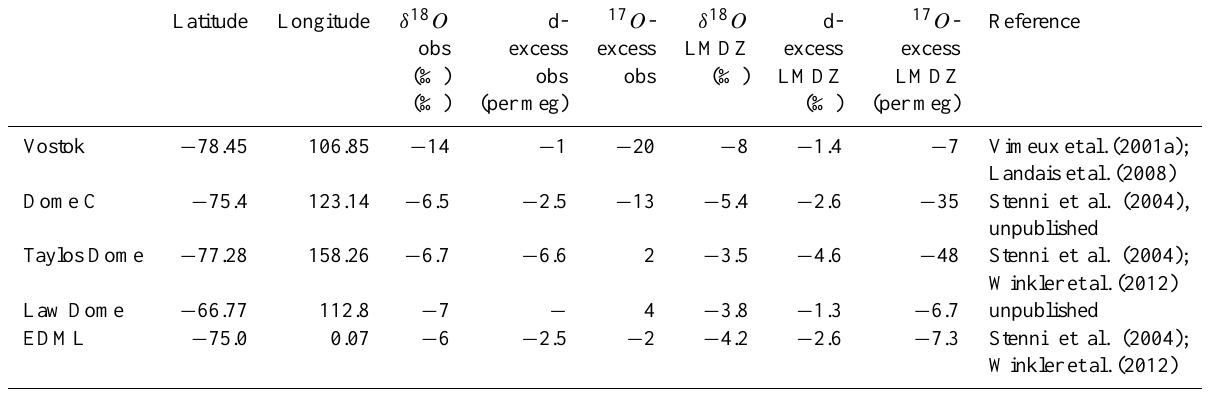
Table 3. LGM minus present-day difference in precipitation δ 18 O , d-excess and 17 O -excess in Antarctica observed in ice cores and simulated by LMDZ.